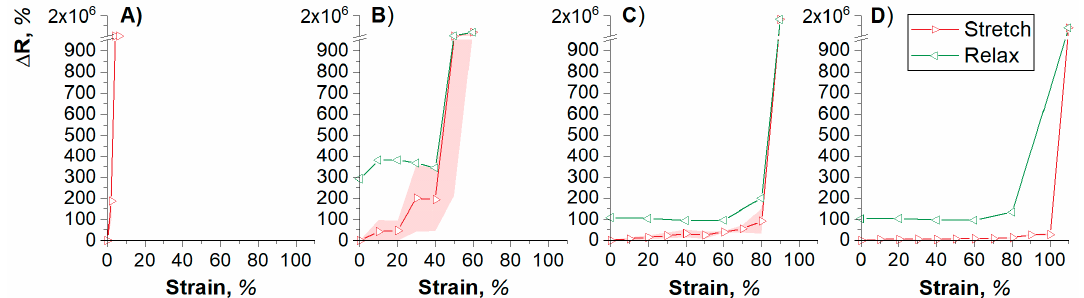
Figure 3. Strain vs. change in resistance profile of PDMS-PEDOT/TOS system under: ( A ) 0% pre-stretch; ( B ) 40% pre-stretch; ( C ) 60% pre-stretch; and ( D ) 80% pre-stretch. The graphs show both the stretching (red) and relaxing (green) cycles and the shaded areas indicate standard deviation (n = 3, plotted as the average ± SD).